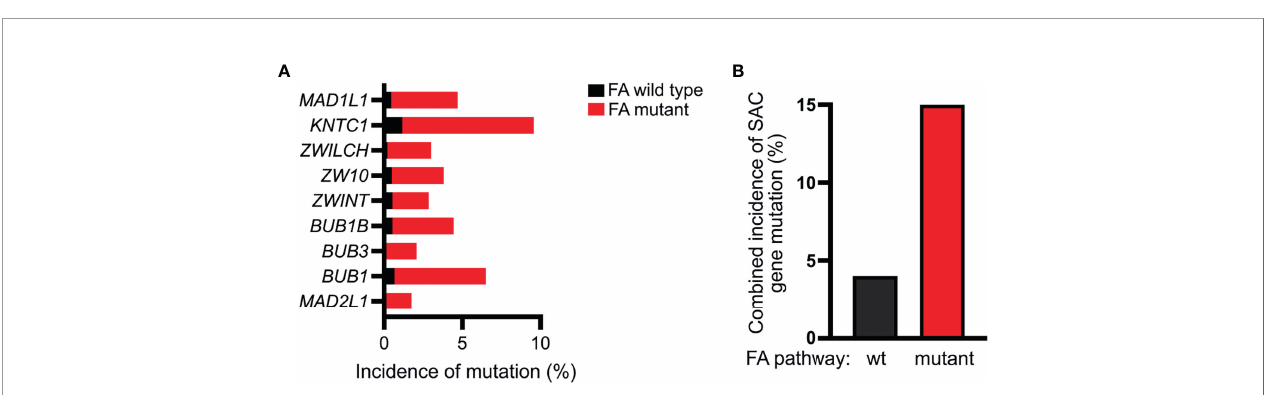
FIGURE 7 | FA-de fi cient cancers exhibit a higher incidence of mutations within genes encoding SAC proteins. (A) Analysis of the TCGA pan-cancer dataset acquired through UCSC Xena browser (xenabrowser.net) demonstrating increased frequency of mutations within genes encoding the indicated SAC proteins in FA- mutant (red) compared to FA-wildtype (black) cancers (B) Accordingly, relative to FA-wildtype cancers (black), FA-mutant (red) cancers exhibit a nearly 4-fold increase in the mutation frequency of one or more of the following SAC genes: MAD1L1, KNTC1, ZWILCH, ZW10, ZWINT, BUB1B, BUB3, BUB1, or